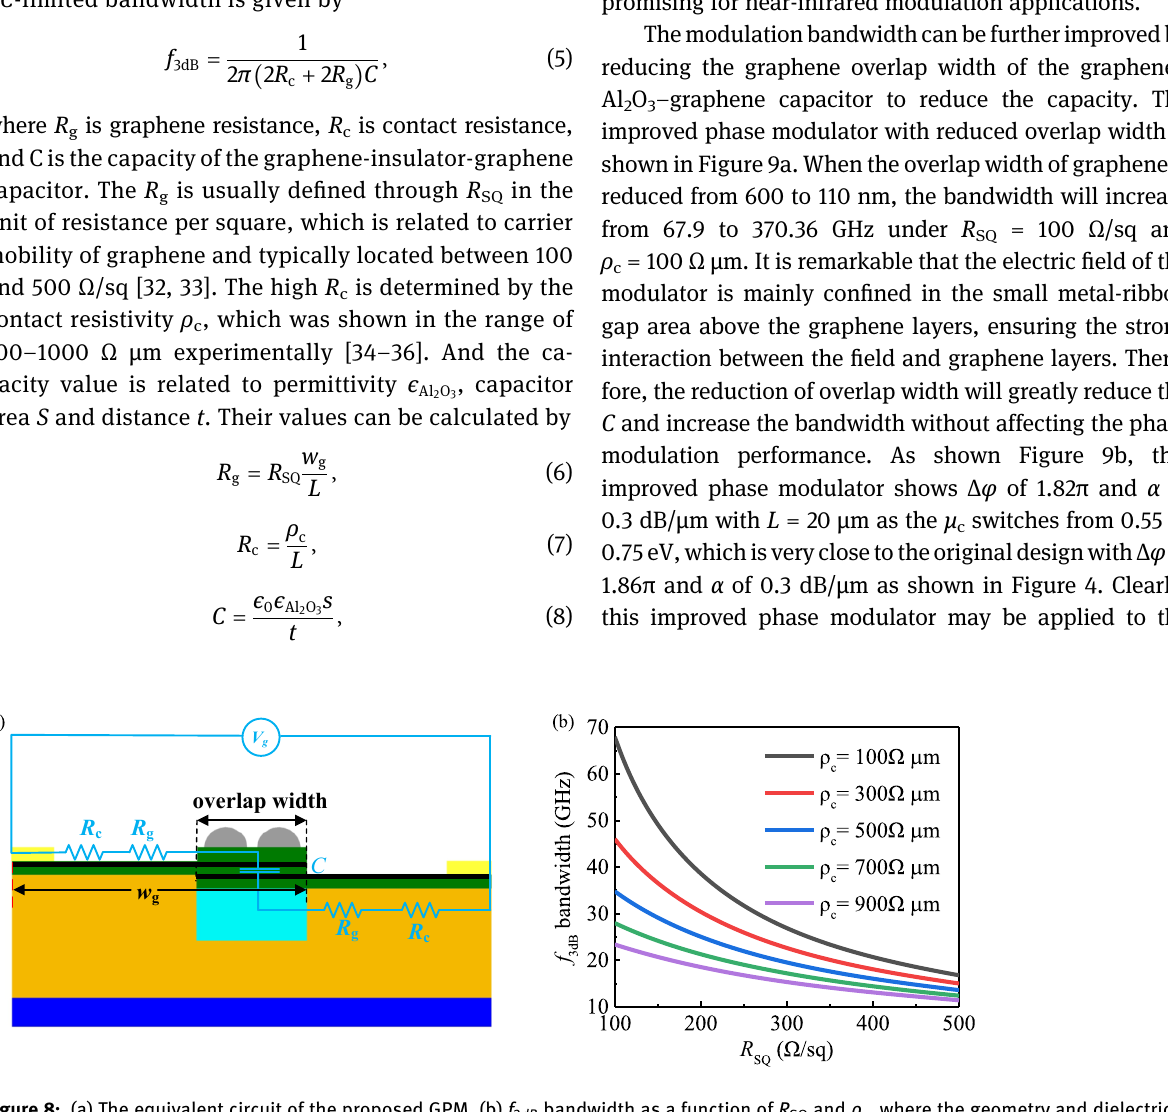
Figure 8: (a) The equivalent circuit of the proposed GPM. (b) f 3 dB bandwidth as a function of R SQ and ρ c , where the geometry and dielectric combination are the same as those in Figure